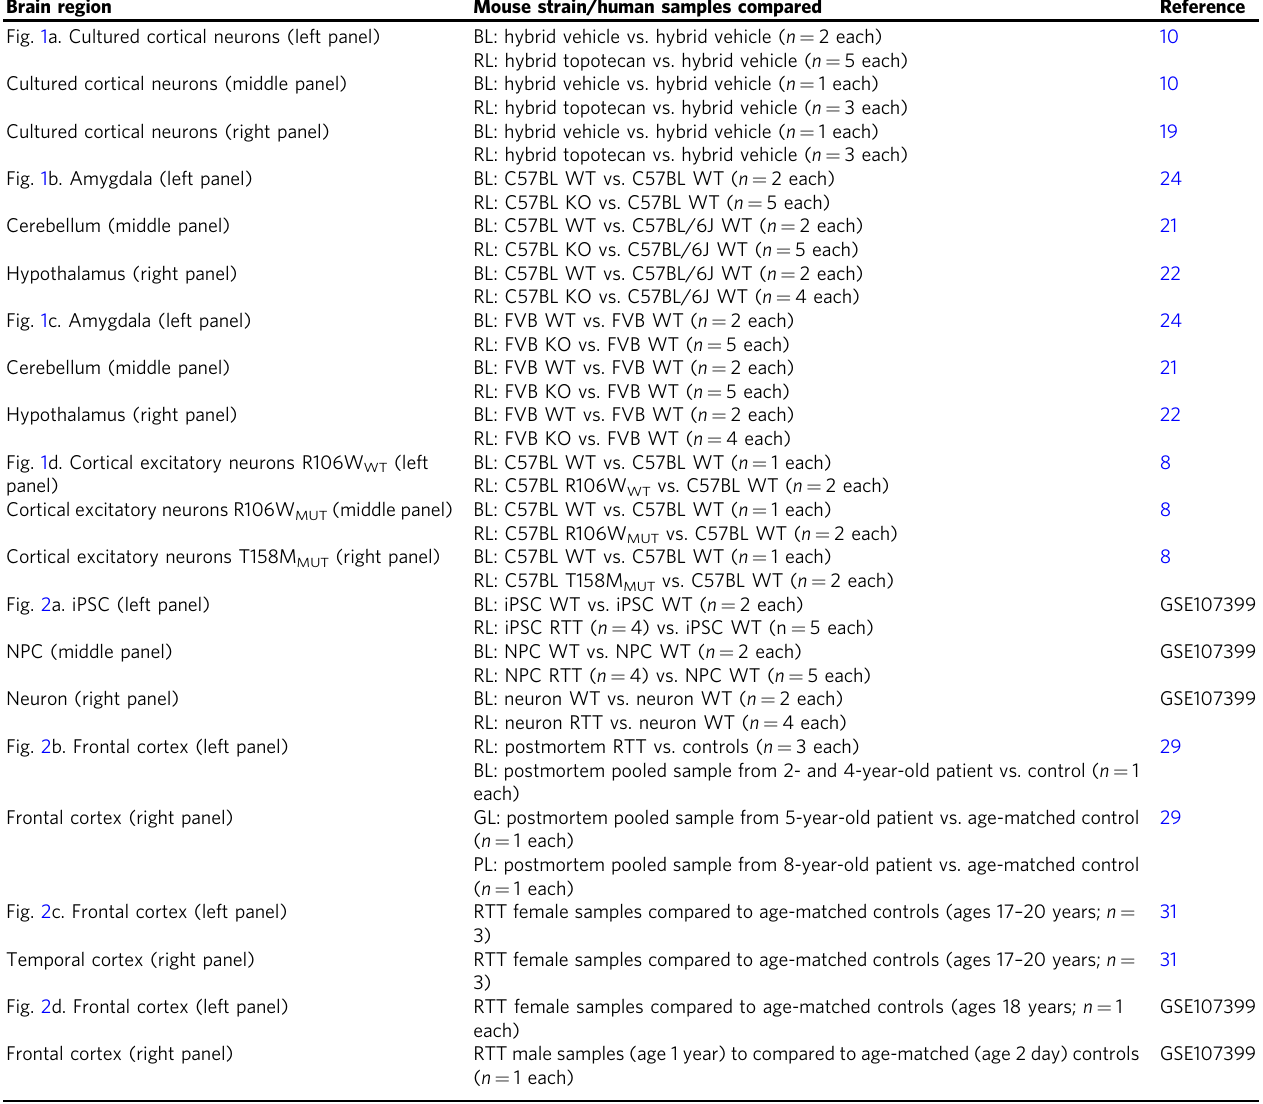
Fig. 1 Establishing baseline length-dependent trends and comparison of MeCP2 microarray and RNA-seq datasets. a Topotecan datasets 10,19 . The top half of each subgraph: comparison of gene expression between cultured cortical neurons from C57BL/6J× CASTEi/J F1-hybrid mice that were treated with vehicle (V) or with other vehicle-treated samples (V/V, blue line), and comparison of topotecan-treated cortical neurons (D) with vehicle-treated samples (D/V, red line). b – d Mecp2 datasets. Note the change in the scale of the y -axis. b Mecp2 -KO datasets. Top half of subgraphs: comparison of gene expression between two sets of WT male C57BL samples (blue line) and comparison of gene expression between male Mecp2 -null (KO) and WT male littermates (red line) in amygdala 24 , cerebellum 21 , and hypothalamus 22 . c MECP2 -overexpression (Tg) datasets. The top half of each subgraph: comparison of gene expression between two sets of WT male FVB samples (blue line) and comparison of expression between Tg samples and WT littermates (red line) in amygdala 24 , cerebellum 21 , and hypothalamus 22 . d Cortical excitatory neurons from Mecp2 -heterozygous female mice. The top half of each subgraph: comparison between two sets of WT C57BL samples (blue line), and the comparison between WT samples and WT neurons from R106W- heterozygous mice (left panel), between WT neurons and Mecp2 -mutant neurons with the R106W mutation (middle panel), and between WT neurons and Mecp2 -mutant neurons bearing the T158M mutation (right panel) 8 . The blue or red line represents fold-change in expression for genes binned according to gene length (bin size: 200 genes; shift size: 40 genes 6 ). The blue and red shaded areas correspond to one-half of one standard deviation of each bin and the bottom half of each subgraph is the P value from two-sample t test between D/V and V/V, KO/WT and WT/WT, Tg/WT and WT/WT, and MUT/ WT and WT/WT in (A – D), respectively. Red dots: bins with FDR < 0.05. The red dashed line at the bottom of subgraphs indicates the minimum − log 10 ( P value) that corresponds to a FDR (false discovery rate) < 0.05. See Table 1 for comparison details and sample numbers. See Supplementary Fig. 1 for our statistical approach and Supplementary Figs. 2 – 4 for the additional analyses from published MeCP2